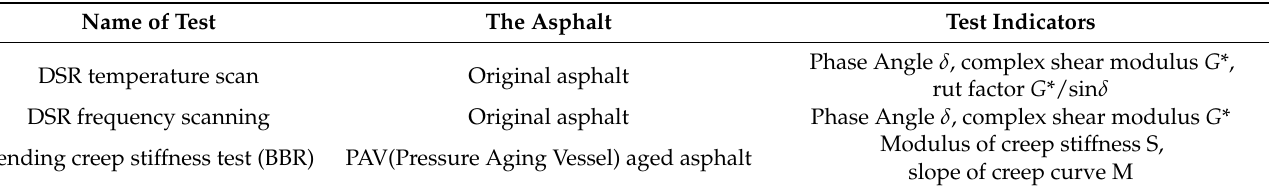
Table 7. Test scheme of asphalt rheological properties.